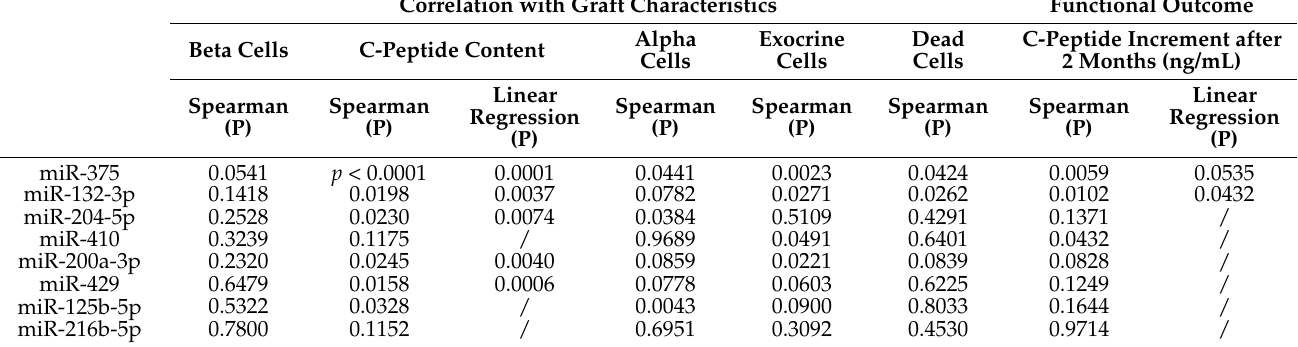
Table 2. Correlation between post-transplant microRNA levels and cellular composition of the islet graft and with secretory graft function 2 months after transplantation. Correlations were analyzed in an independent validation cohort 3 of patients ( n = 46) receiving at least 2 million beta cells/kg BW, on RQ levels for the indicated microRNAs calculated on paired 1 h post-transplant versus pre-transplant samples for each individual patient. The left panel lists the statistical significance ( p -value) of Spearman’s rank correlation of RQ to the composition of the grafts in terms of number of insulin-positive cells, C-peptide content, number of glucagon-positive cells, exocrine cells and dead cells measured just prior to implantation. The right panel indicates the correlation of RQ values to the magnitude of the C-peptide increment two months after transplantation [1,9,12] as an indicator of late-stage insulin secretory function of the graft. For correlation with C-peptide and functional graft outcome, multivariate analysis with multiple linear regression was additionally done for parameters retained as significant in univariable